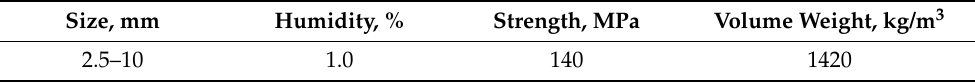
Table 2. Properties of heavy aggregate from crushed stone